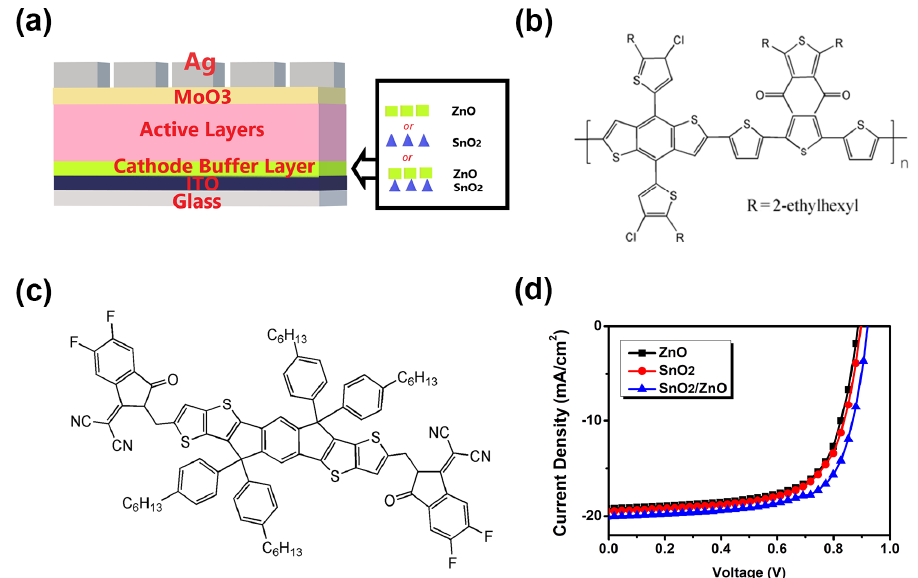
Figure 1. ( a ) Device architecture and photoactive materials; ( b ) PM7 (where n indicates the degree of polymerization); ( c ) IT-4F; ( d ) The J-V characteristic curves of the OSCs with ZnO, SnO 2 and SnO 2 /ZnO cathode buffer layers.